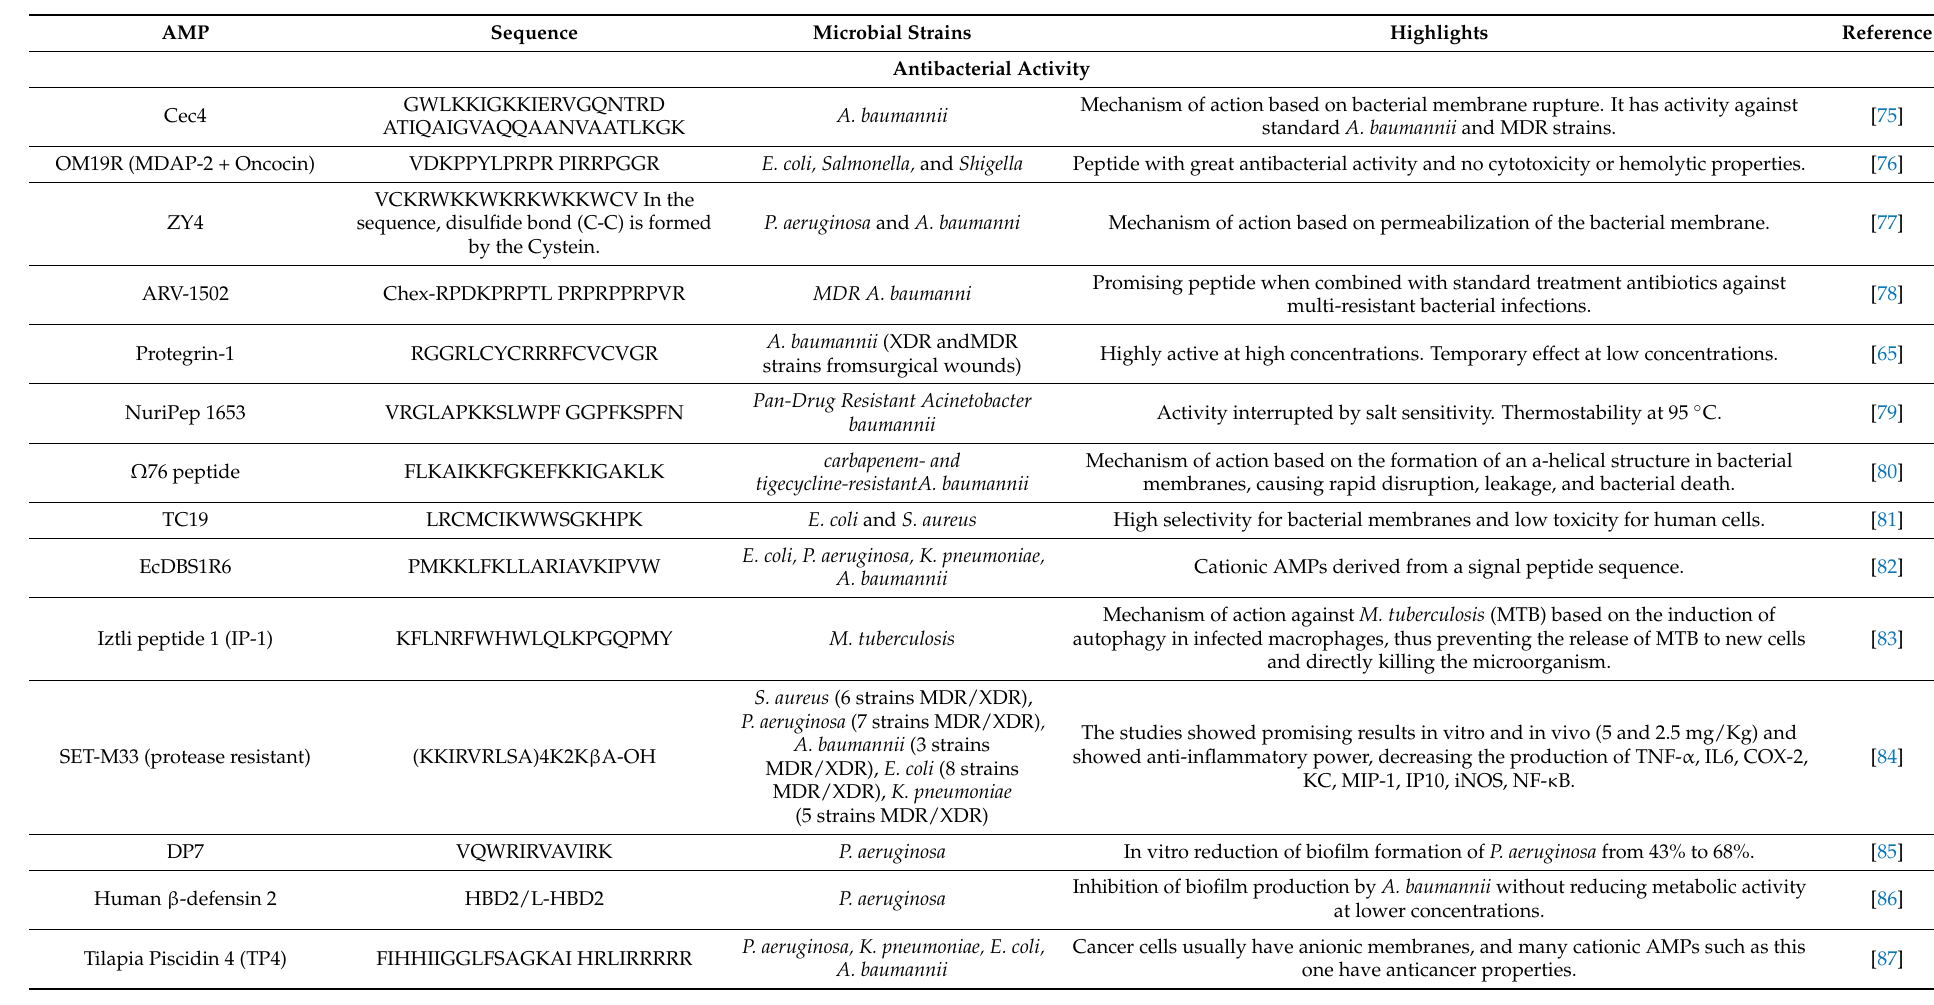
Table 2. Examples of antimicrobial peptides (AMPs) and their potential antibacterial properties against infectious, MDR bacteria and some infective fungi and